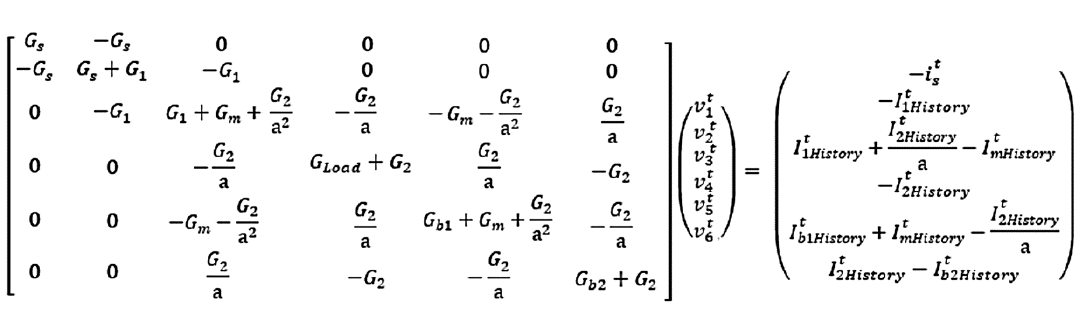
Figure 12. Test circuit in the form of Equation (3).